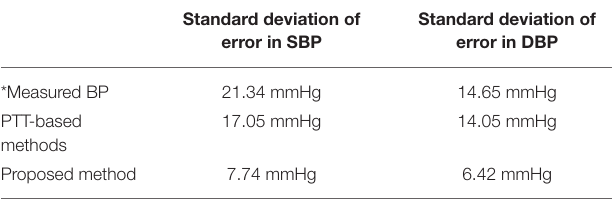
TABLE 5 | Comparison of conventional PTT-based methods and the proposed